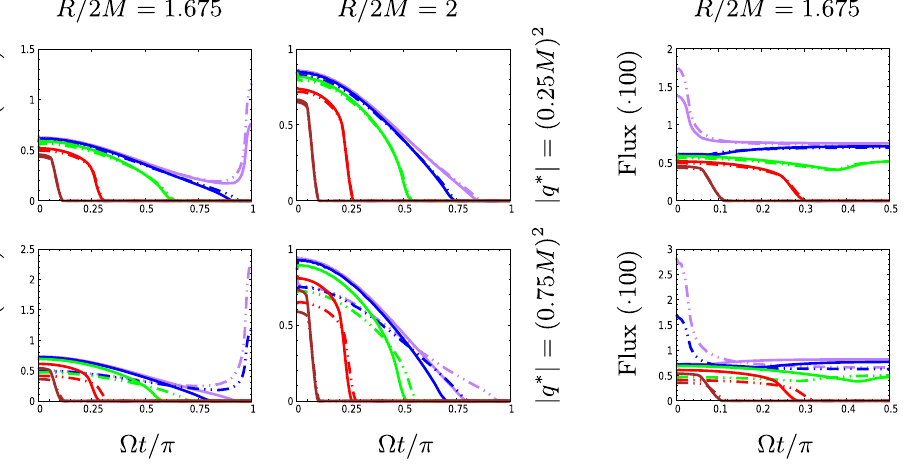
Fig. 28 Pulse profile for antipodal caps. Exponential decay, ξ = χ = π/ 2. Purple, blue, green, green, red and brown lines correspond to (cid:11) = 0 . 00, 0 . 30, 0 . 60, 0 . 90 and 0 . 99 respectively. The solid lines correspond to q ∗ > 0 while the dashed lines correspond to q ∗ < 0